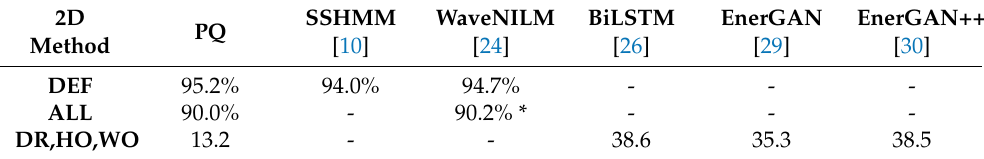
Table 6. Comparison of the best-performing proposed 2D transformation method (PQ) with state-of- the-art performances reported in the literature in terms of E ACC and MAE (* the approach utilizes the next-to-active and reactive power and current and apparent power as its input